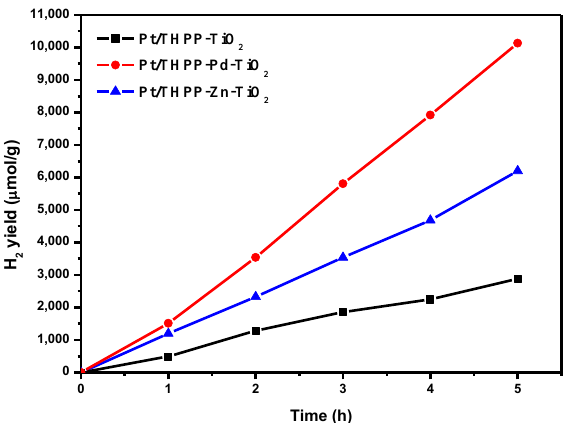
Figure 6. H 2 production curves of Pt / THPP-TiO 2 , Pt / THPP-Pd-TiO 2 , and Pt / THPP-Zn-TiO 2 in an aqueous solution of 10% TEOA under visible-light irradiation ( λ > 420 nm).